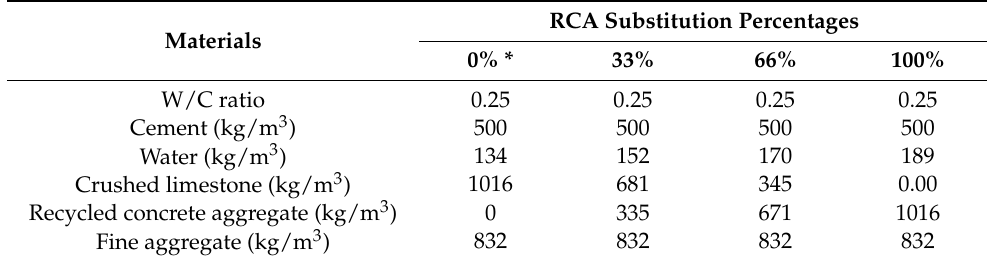
Table 1. Concrete mixture proportions to produce HSC